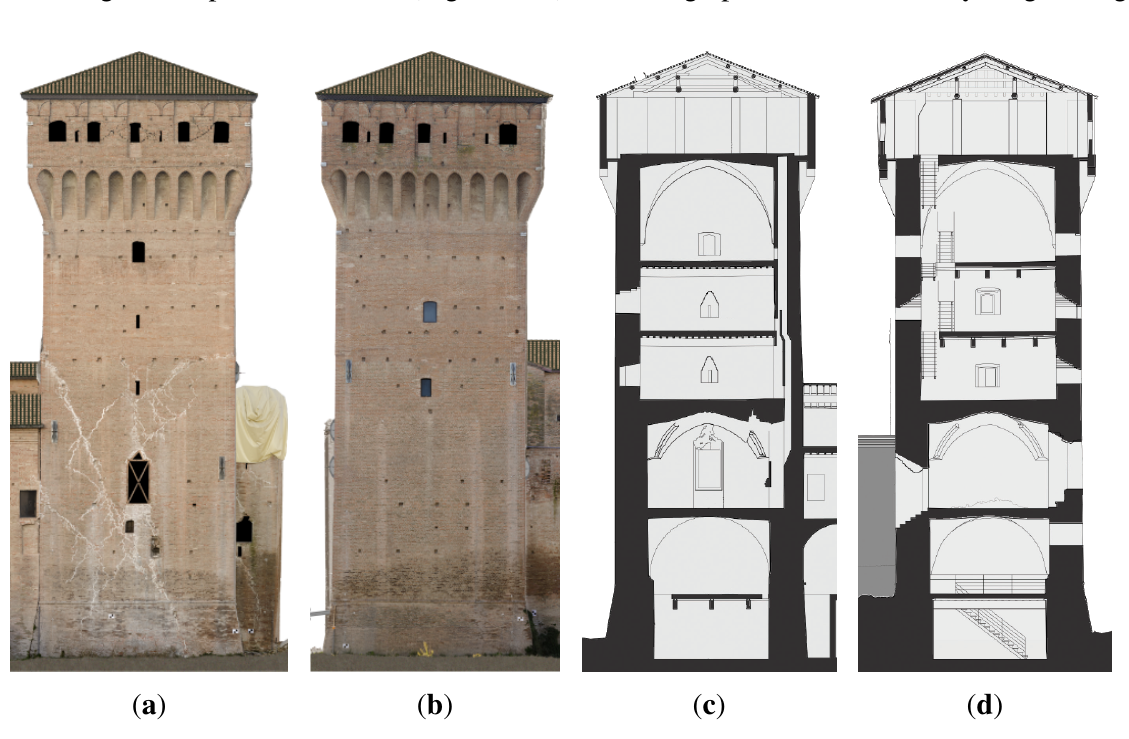
Figure 6. San Felice sul Panaro Fortress principal tower. ( a ) South front; ( b ) east front; ( c ) E-W section; ( d ) S-N